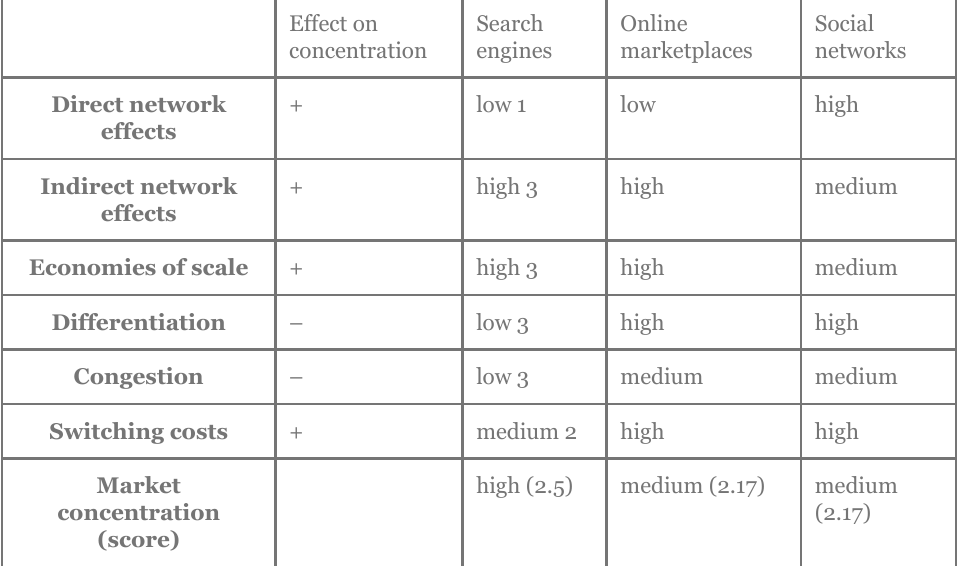
Table 3: Market Concentration Forces. Strength of market concentration forces for different types of platform markets. The concentration score indicates the degree of market concentration, with 1 ≤ score < 1.75 indicating low market concentration, 1.75 ≤ score < 2.5 indicating medium market concentration, and 2.5 ≤ score < 3 indicating high market